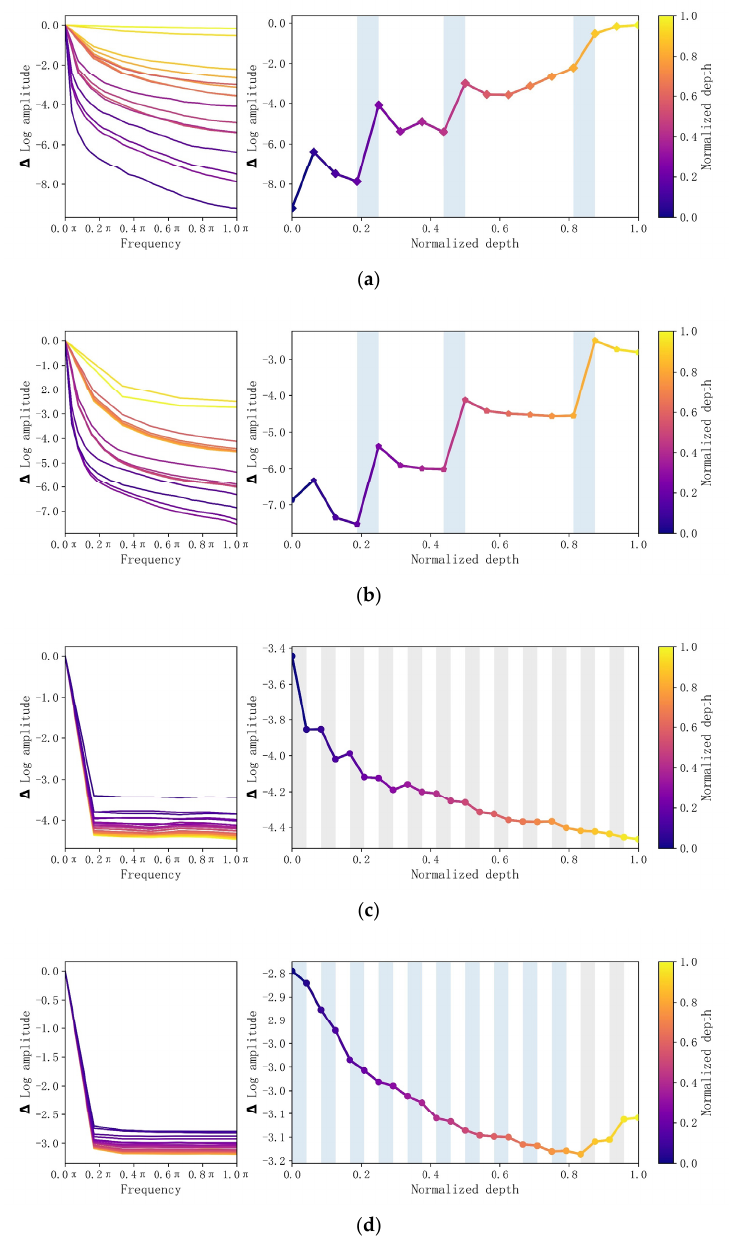
Figure 14. Relative log amplitude of the Fourier transform of the model feature maps ( a ) ResNet, ( b ) BoTNet, ( c ) ViT and ( d ) ConViT.